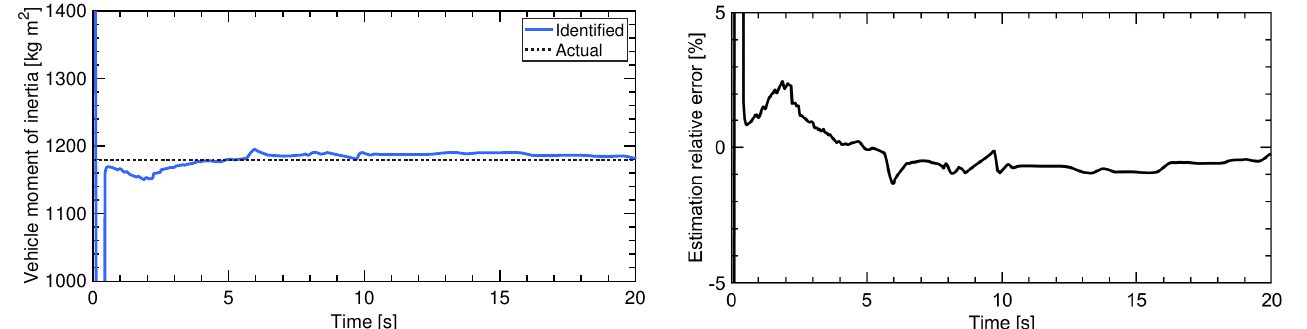
Figure 29. Identification of moment of inertia: identified value ( left ) and relative error ( right